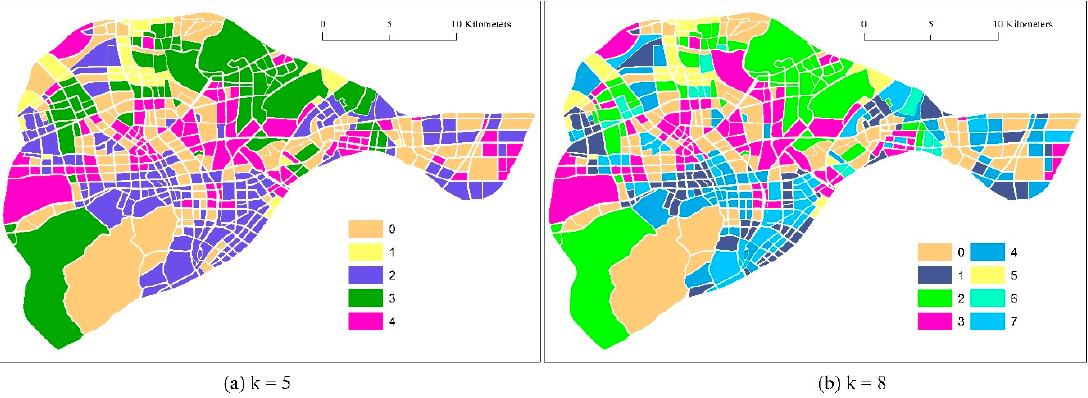
Figure 6. The clustered results when k = 5 ( a ) and k = 8 ( b